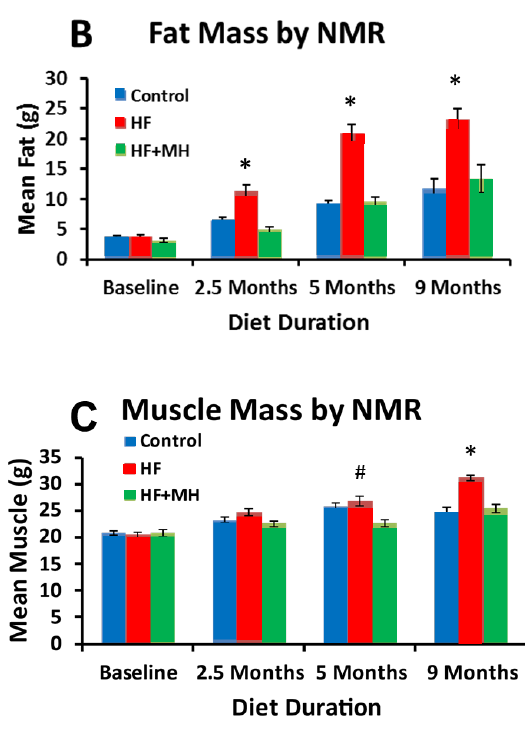
Figure 1. ( A ): Comparison of mean body weights by month for mice across the duration of the study (Ns = 7–8). ( B ): Comparison of fat mass by NMR at baseline and after 2.5 and 5 months on diets (Ns = 12–16), and 9 months on diets (Ns = 7–8). ( C ): Comparison of muscle mass by NMR at baseline and after 2.5 and 5 months on diets (Ns = 12–16), and after 9 months on diets (Ns = 7–8). # = p < 0.05 & * = p < 0.01 compared to controls. HF: high-fat, MH: mannoheptulose.